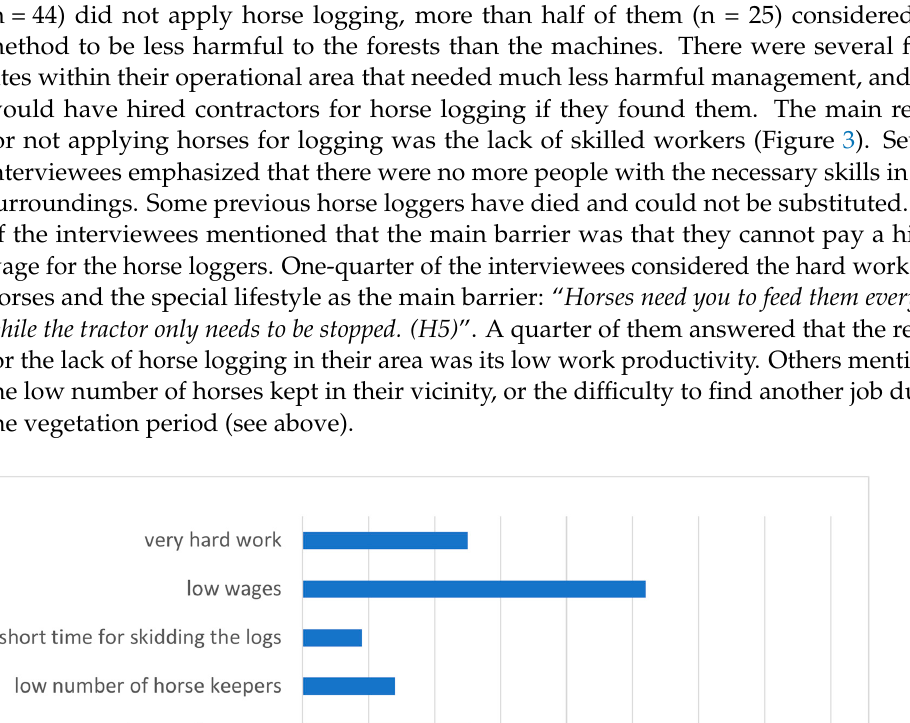
Table 5. Advantages and disadvantages of horse logging. Advantages of Horse Logging Compared to Using Machines